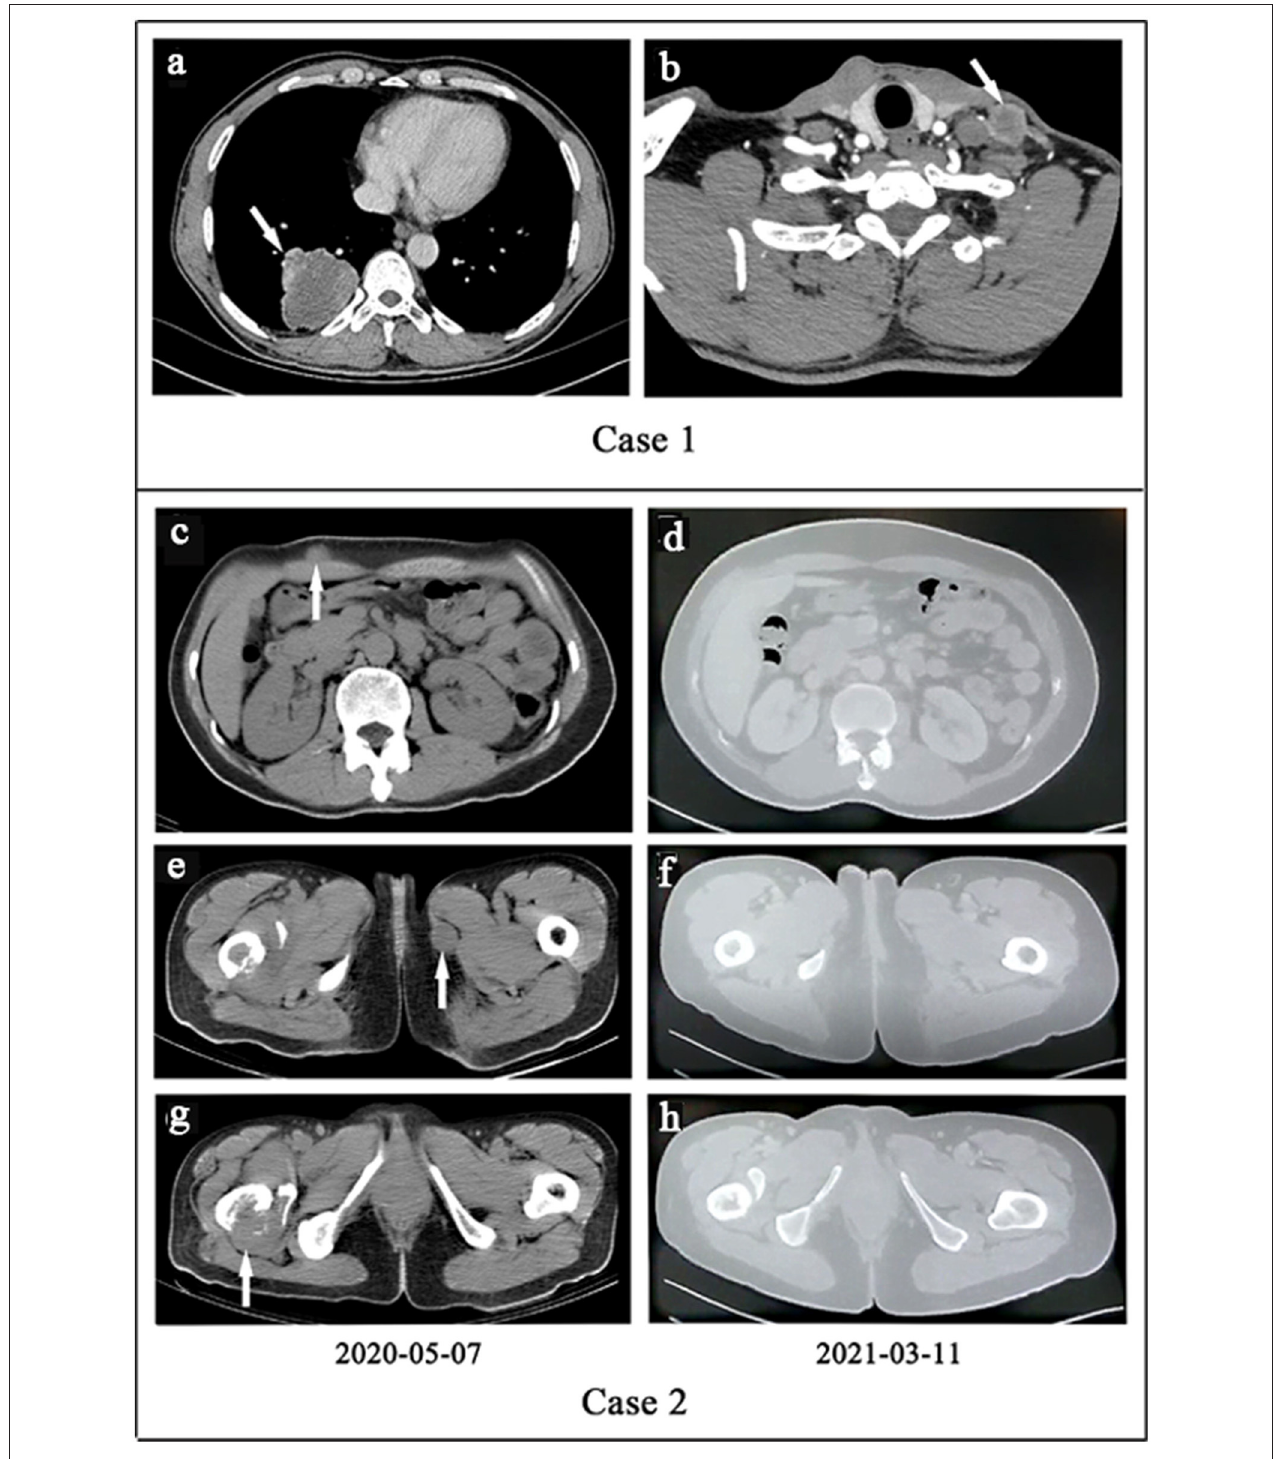
FIGURE 1 | (a,b) Case 1. (a) The computed tomography (CT) of primary lesion revealed a large, irregular mass with a non-uniform density shadow attached to the lower lobe of the right lung. (b) The CT of metastatic lesion showed an uneven density lesion within subcutaneous of the left neck with an unclear border. (c–h). Case 2. Treatment efficacy with Alectinib in Case 2 based on CT scans. (c,e,g) Before Alectinib treatment. Multiple low-density nodules were observed in subcutaneous of the right upper abdomen, the inner side of the left thigh, and the right femur. (d,f,h) Ten months after Alectinib treatment, multiple soft tissue density nodules decreased or